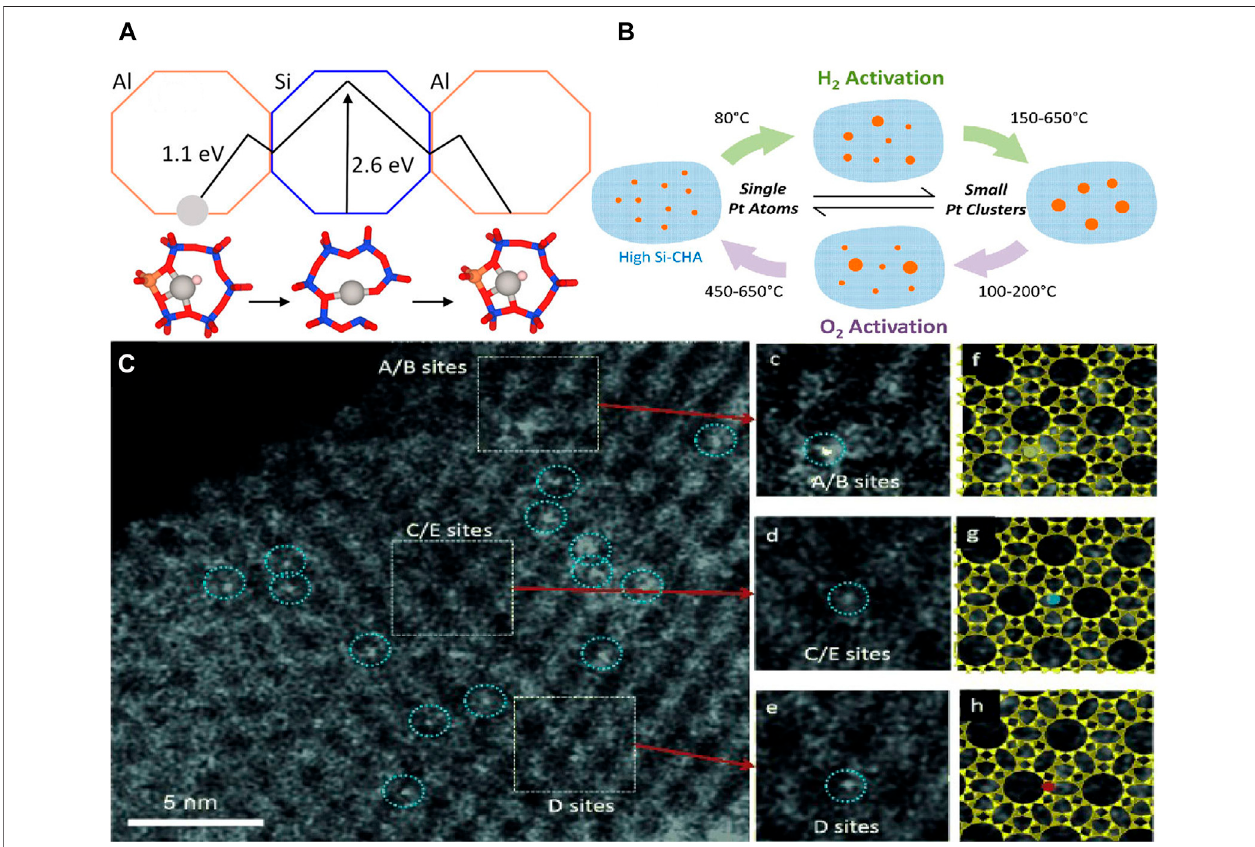
FIGURE 3 | (A) Diagram of positional migration and effective energy of metal atoms in zeolite (Hou et al., 2020). Copyright 2020, American Chemical Society. (B) Conversion ofcatalysts in different atmospheres (Moliner et al., 2016). Copyright 2016, American Chemical Society. (C) STEMimagesshowing site-isolated Ptatoms in KLTL zeolite in the as-prepared samples (Kistler et al., 2014). Copyright 2014, Wiley.